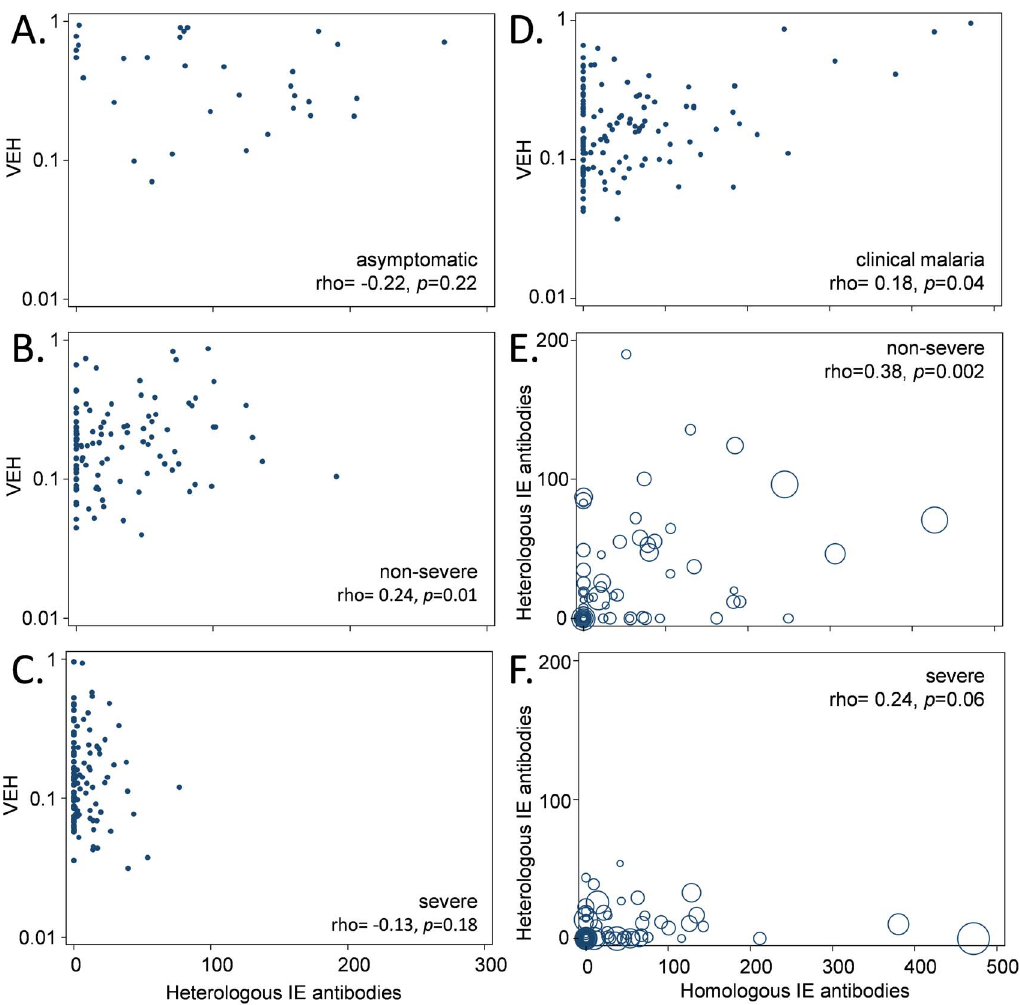
Figure 4. The relationship between VEH and host IE surface antibodies to heterologous and homologous isolates. A-C show scatter plots of the relationship between VEH and breadth of the heterologous IE surface antibody response as in Figure 3A, but split into asymptomatic (A), non-severe (B) and severe malaria (C). (D) Shows the relationship between VEH and the homologous IE surface antibody response to each child’s own parasites among children with malaria (measured as mean fluorescence intensity). Among children shown in (D), (E-F) compares the heterologous and homologous responses among those with non-severe (E) and severe (F) malaria, respectively. The size of the marker in (E-F) is proportional to VEH. Spearman’s rho was used to test for